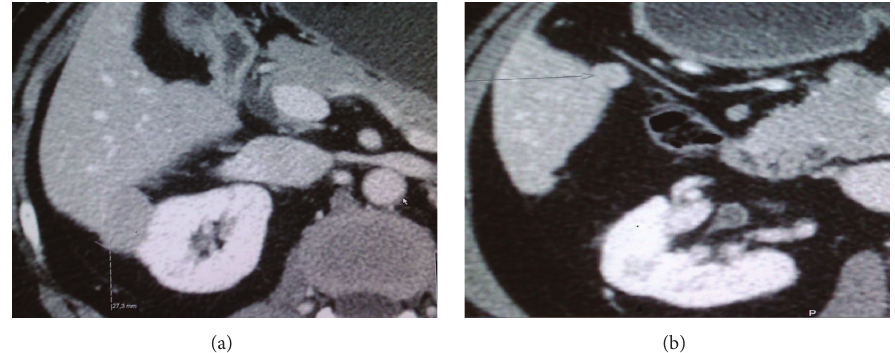
Figure 2: CT with intravenous contrast. Two lesions detected. First lesion adjacent to lateral part of right kidney, largest diameter 2.7 cm (a). Second lesion close to duodenum, largest diameter 1.4cm